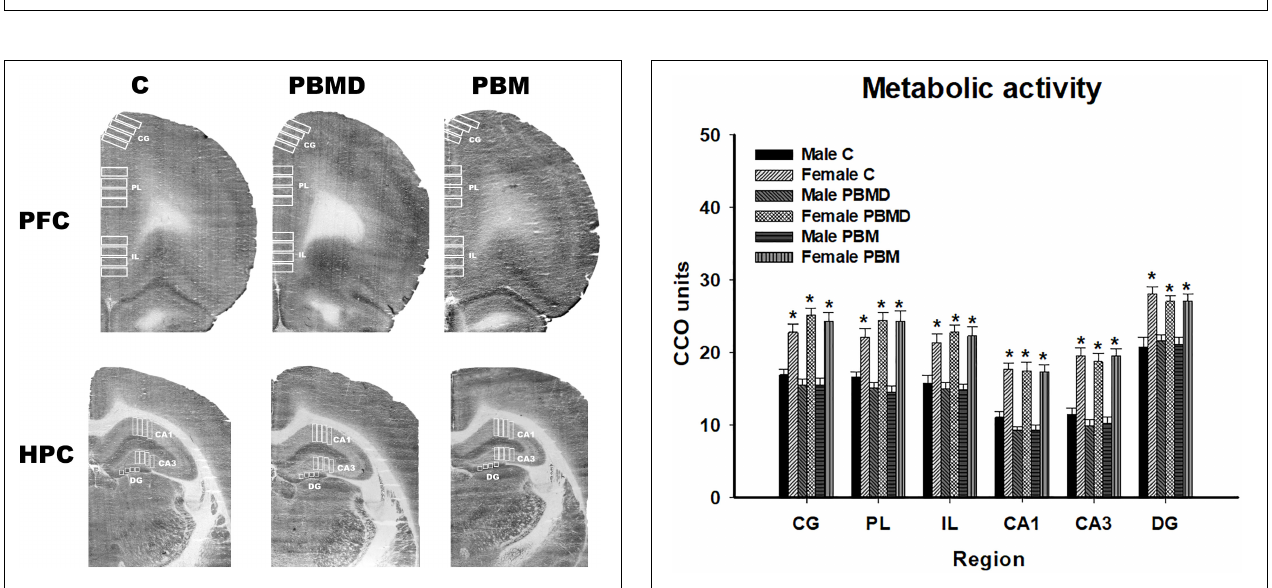
p = 0.133]. Post hoc comparisons showed more c-Fos positive nuclei in male groups in CG ( t = 2.747, p = 0.009), PL ( t = 2.634, p = 0.012) and IL ( t = 3.031, p = 0.004) while, in contrast,